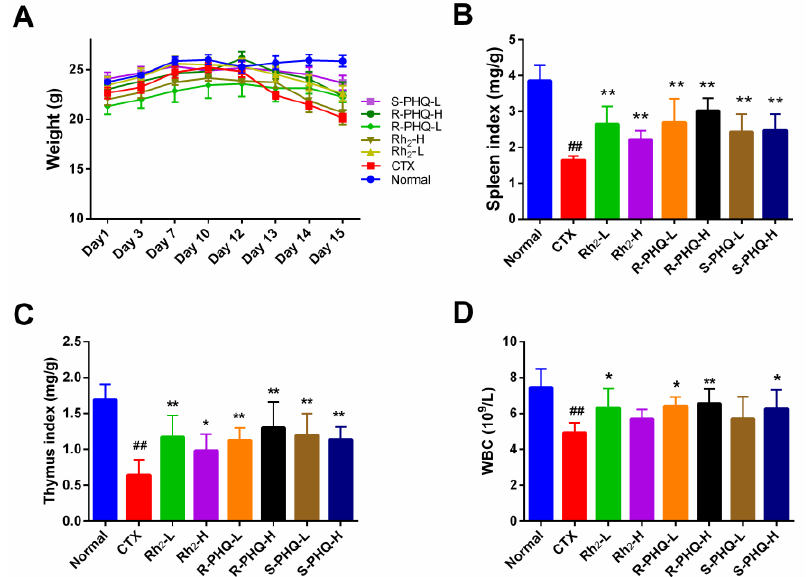
Figure 1. Effect of Rh 2 , R-PHQ, and S-PHQ on ( A ) body weight; ( B ) spleen index; ( C ) thymus index; ( D ) WBC. The values are presented as mean ± SD, n = 10. ## p < 0.01 compared with the normal group. ** p < 0.01 and * p < 0.05 compared with the CTX group.